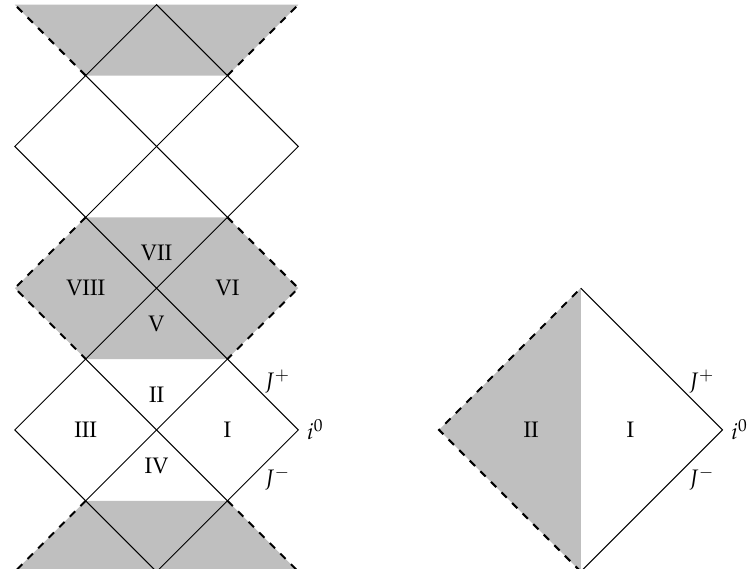
Figure 1. Conformal diagram of the spherically symmetric solution with the Lambda-function (11) and with the Schwarzschild radius r g ( ∞ ) > r c (left image) and r g ( ∞ ) < r c (right image), with r c given in Equation (21). Different regions are numbered in such a way that the coordinate t is timelike in the odd regions, and spacelike in the even ones. The flow of time is vertical in the white regions and changes to horizontal in the grey regions. The boundaries between grey and white regions are places where metric changes signature and, therefore, becomes singular. Thick dashed lines indicate the true singularity, where r = ∞ and ψ = ∞ . The configuration on the left image extends periodically and indefinitely upward and downward. We are living in one of the regions of type I; the asymptotic spatial infinity in this region is denoted by i 0 , and the future and past null infinities are denoted by J + and J − ,